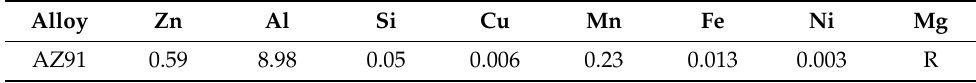
Table 1. Chemical composition of the investigated alloy